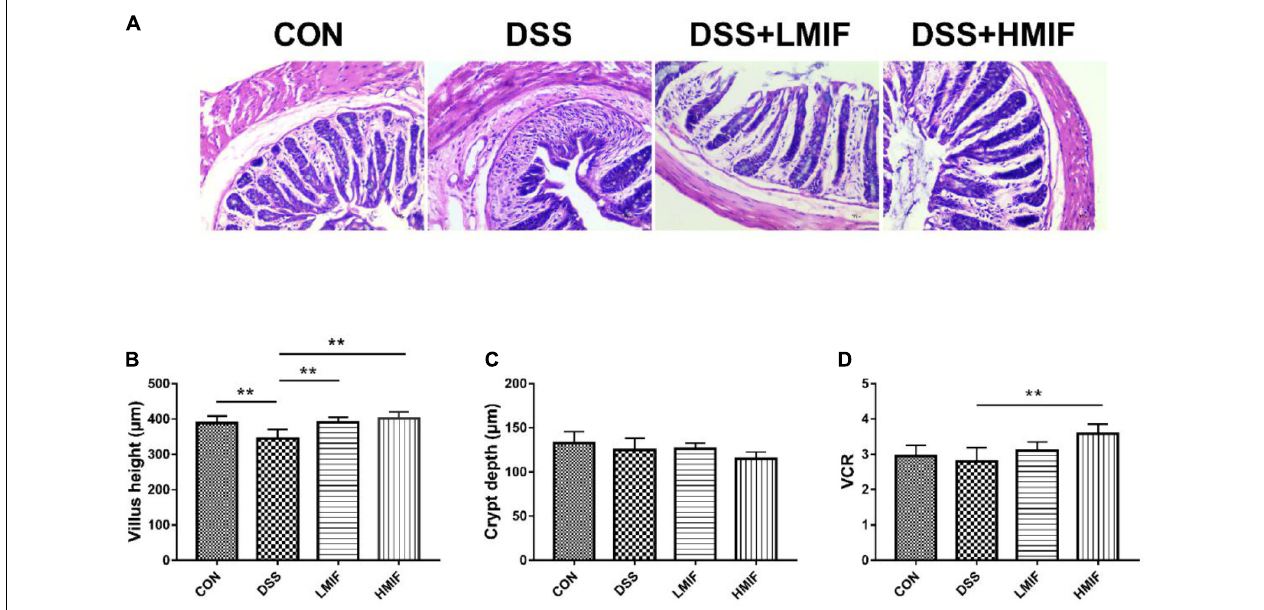
FIGURE 1 | Effects of Morchella importuna flavones on colonic morphologies in dextran sulfate sodium (DSS)-challenged mice. (A) Colonic morphological image; (B) villus height; (C) crypt depth; (D) ratio of villus height to crypt depth (VCR). CON, control; DSS, DSS treatment; LMIF, DSS treatment + 100 mg/kg fruiting bodies of